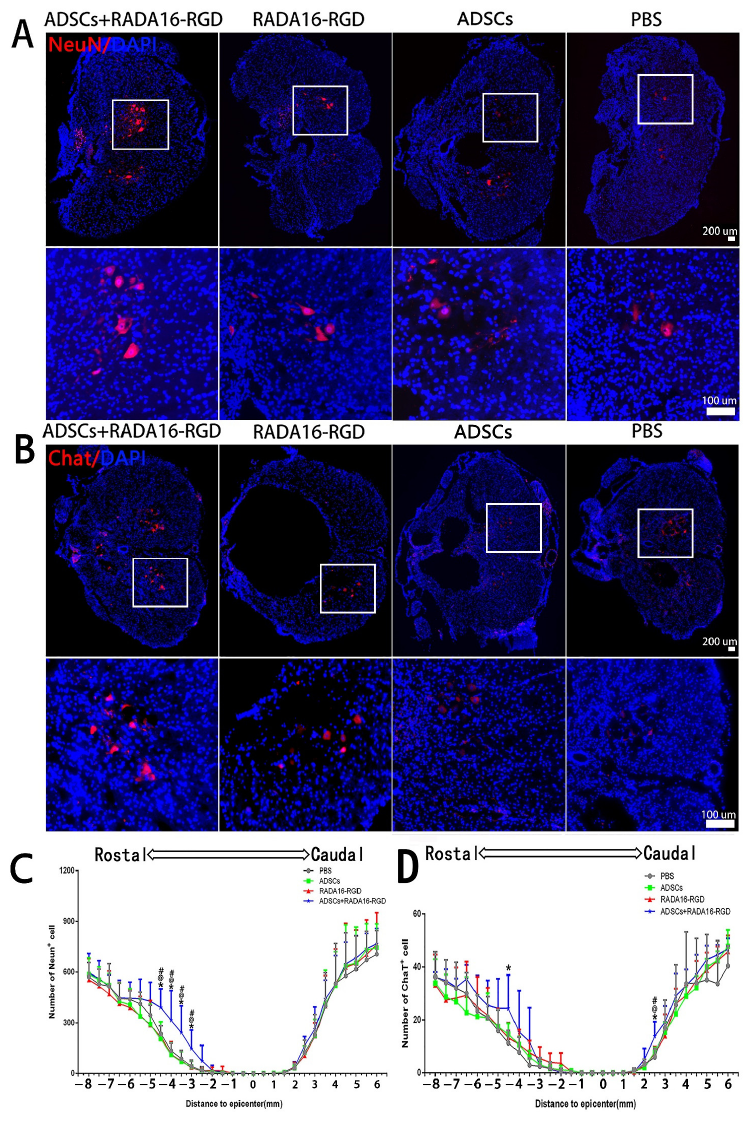
Figure 4. ADSCs+RADA16-RGD transplantation contributes to neuronal survival in rats with spinal cord injury. ( A ) NeuN antibody staining (red) at −4.5 mm cephalic to the injury at 8 weeks after PBS,